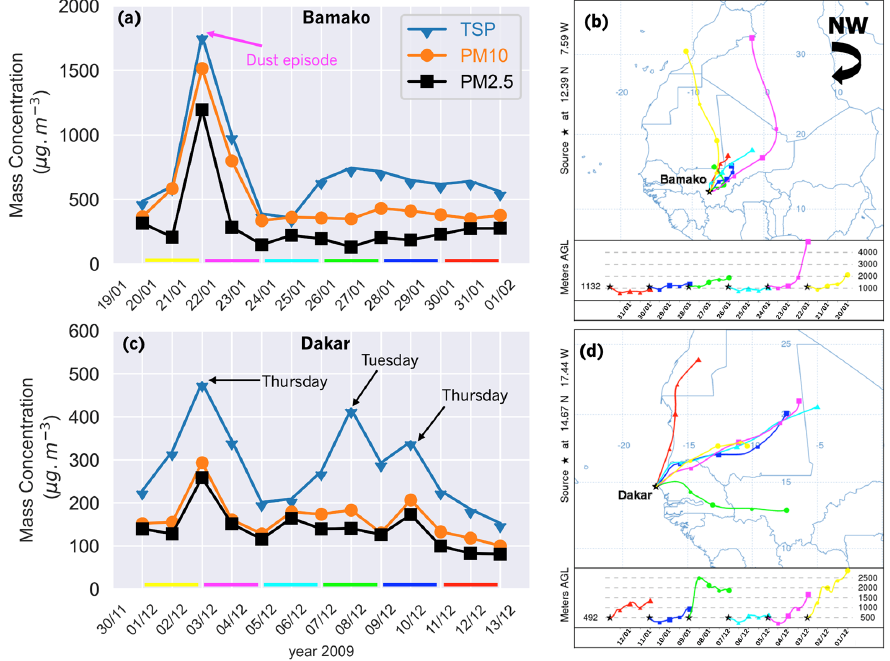
Figure 4. Map of the daily evolution of PM (TSP, PM 10 , and PM 2.5 ) mass concentrations ( a ) in Bamako and ( c ) Dakar, as well as HYSPLIT 48 h air mass back trajectories arriving ( b ) in Bamako for the period from 20 January to 1 February 2009, and ( d ) in Dakar for the period from 1 to 13 December 2009. The individual 48 h back trajectories are represented by color lines.